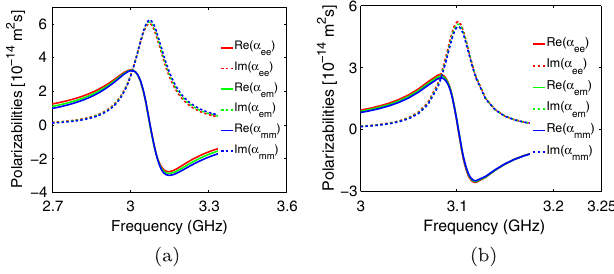
FIG. 5. Individual normalized polarizabilities of the designed (a) single- and (b) double-turn helical inclusions.